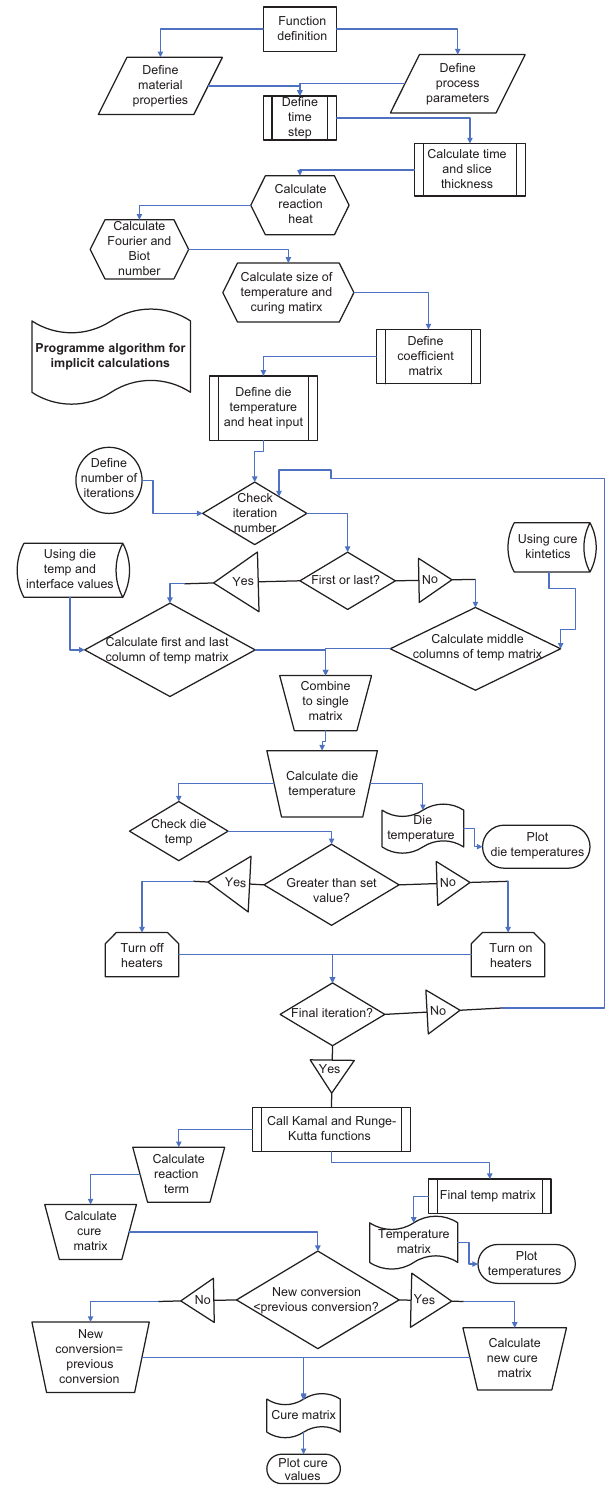
Figure 2 Flow chart for model algorithm of the solution of heat transfer